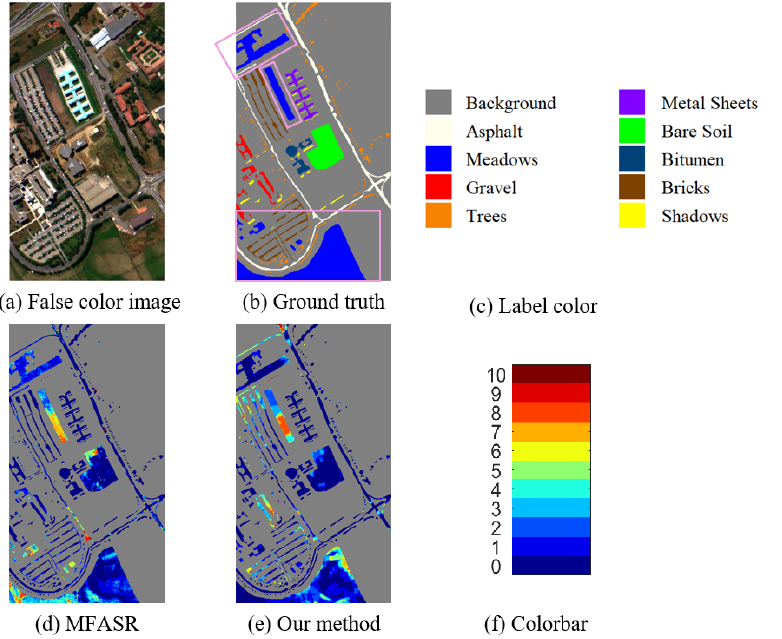
Figure 9. Results for the PaviaU dataset. ( a ) The false color image. ( b , c ) The ground truth and the corresponding label colors. ( d , e ) The misclassification counts of MFASR and our method. ( f ) The colorbar represents the misclassification counts.